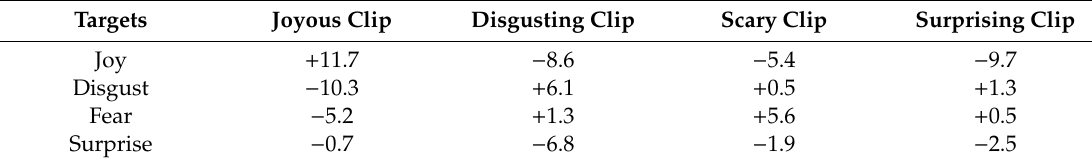
Table 1. Implicit responses: facilitation indices per target pair for each clip.